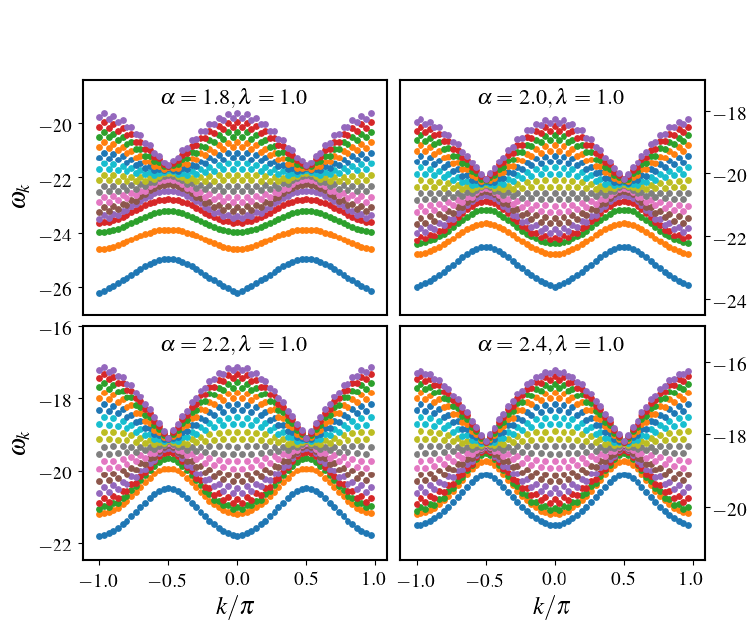
Figure 5: Two-spinon spectra for λ = 1 and different values of α obtained by using Villain’s approach for L = 60, as described in the